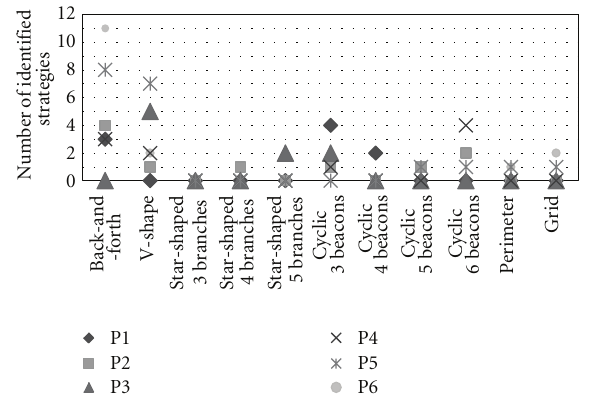
Figure 6: Number of exploration strategies for each participant during the memorization